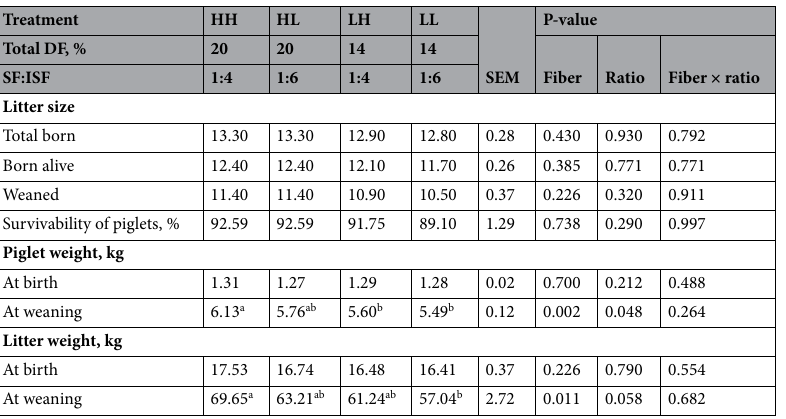
Table 3. Effects of total dietary fiber levels and soluble, insoluble dietary fiber ratio on piglet performance. SEM standard error of means, DF dietary fiber, SF soluble fiber, ISF insoluble fiber. a,b Means with different superscripts within rows are significantly different at (P <